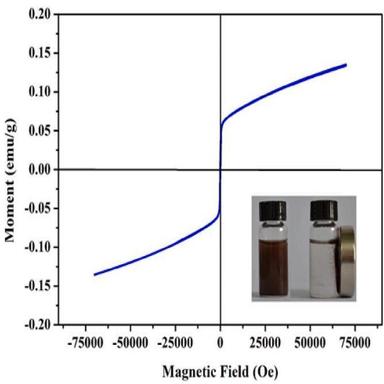
VSM curve of FLPWAC composite.